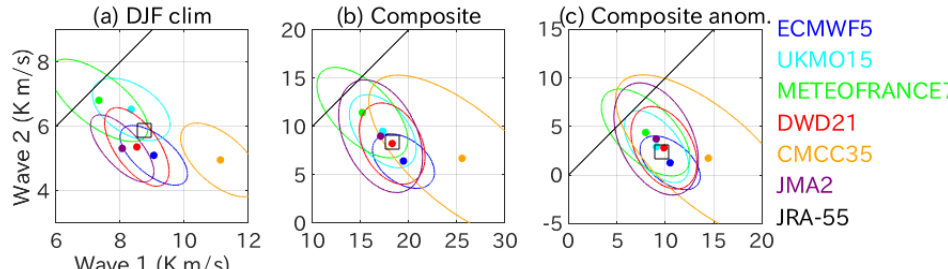
Figure 3. ( a ) Scatter plot between the climatological wave 1 and wave 2 heat flux ( x and y axis, respectively) in 45–75 ◦ N, 100 hPa during DJF. Each dot plots the ensemble mean result for each system. Each ellipse plots a representative distribution of the ensemble members for each system. The directions of the long and short axes are extracted by EOF analysis. The length of each axis is the 99 percentile of the distance values, from the center of the ellipse to the ensemble members projected onto the axis. Black square plots the JRA-55 result. Black line denotes the y = x line. Panel ( b ) is similar, but for the composite heat flux with respect to the MSSW central date. Time means are taken from lag = −10 to 0 day for both components. Panel ( c ) is similar to ( b ), but uses heat flux anomalies.